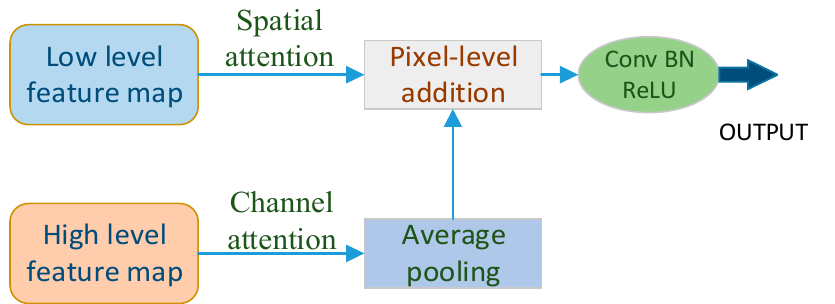
Figure 5. The semantic segmentation network structure.